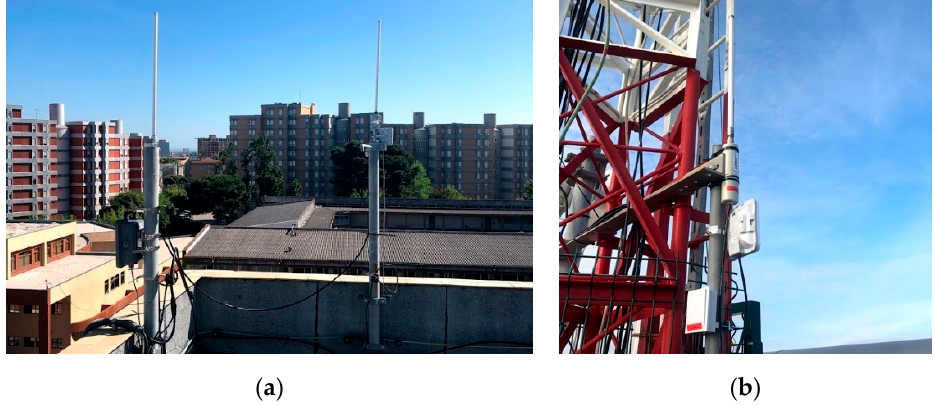
Figure 3. LoRa gateways deployed at ( a ) ISEL and ( b ) Amoreiras.